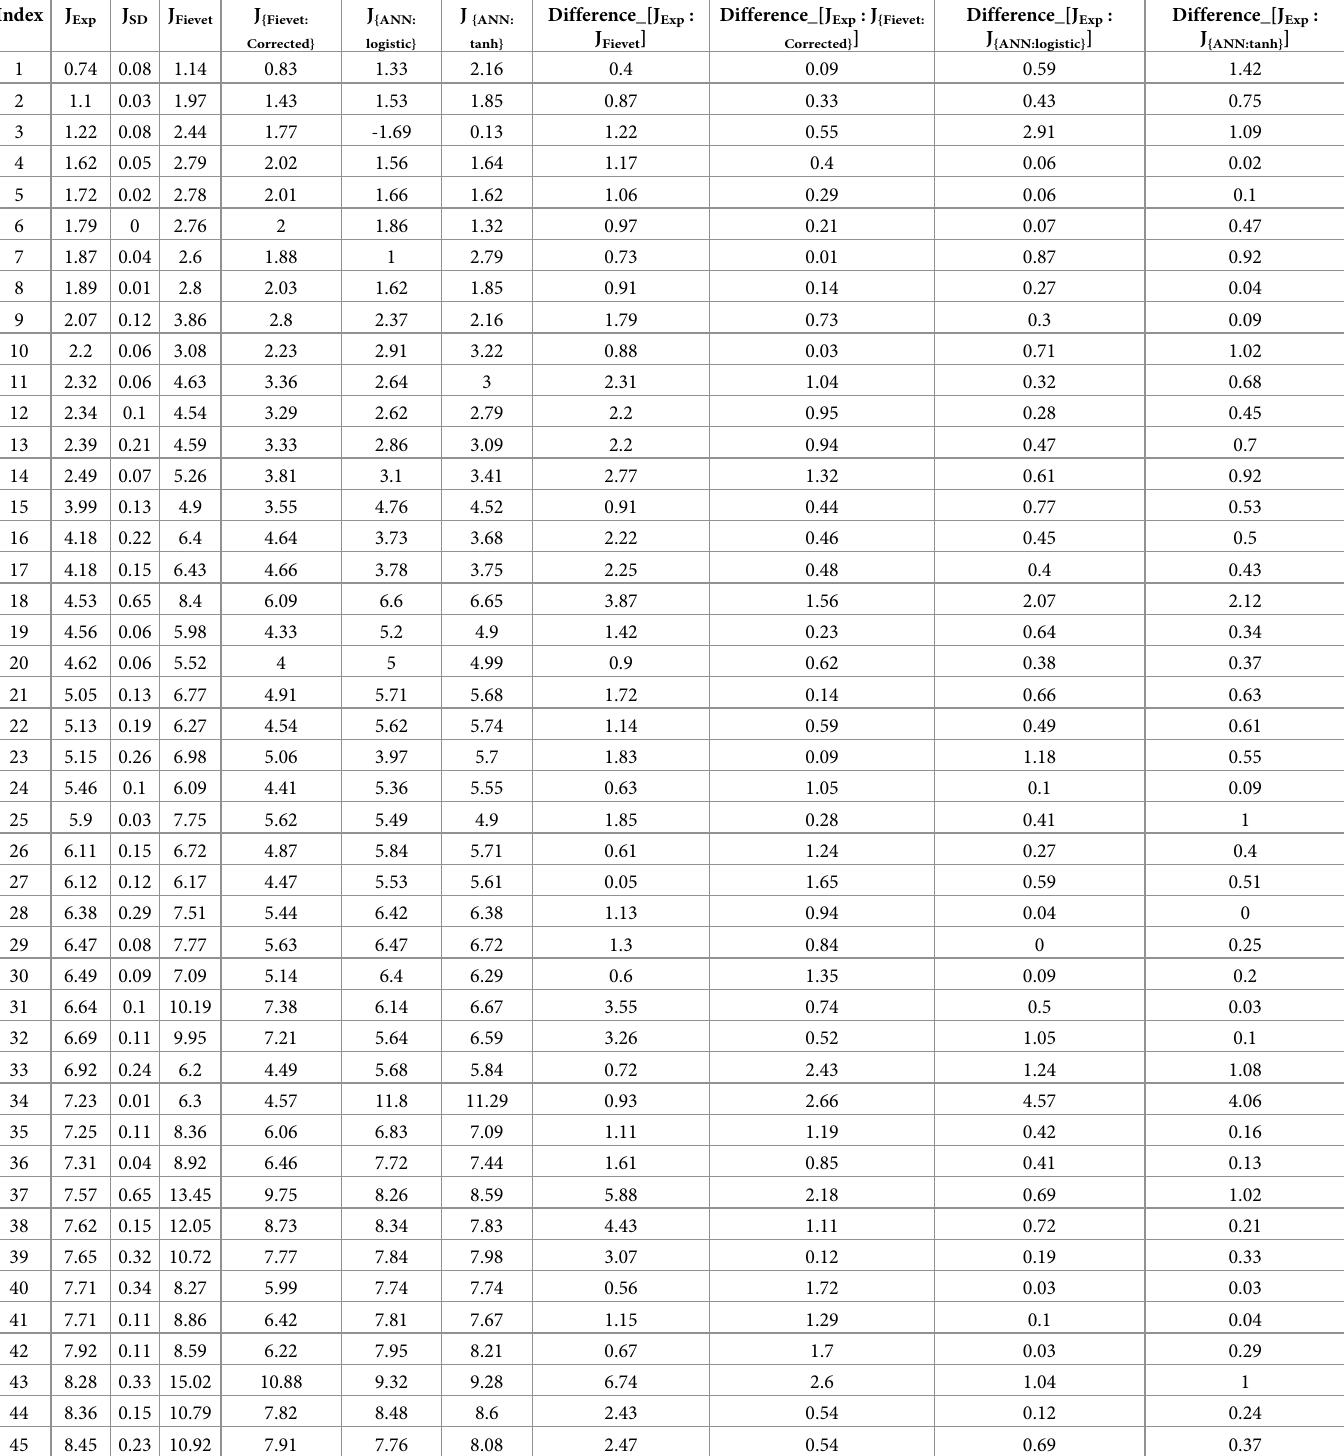
Table 1. Comparison of flux values (in μ M/S) between observed flux (J Exp ), J.B Fievet (J Fievet )and ANN predicted flux with activation functions logistic (J {ANN: logis- tic} ) and tanh (J {ANN: tanh} ) and the standard deviation of observed flux (J SD